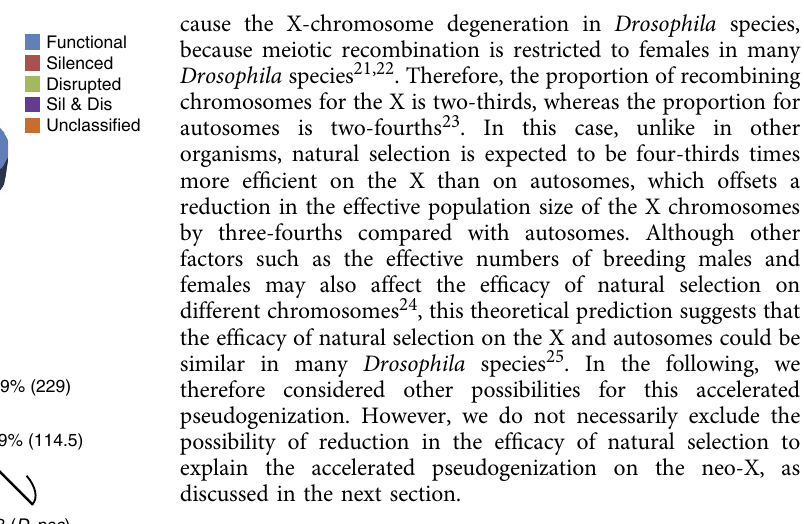
before separating the neo-X and neo-Y; X , the neo-X branch; Y , the neo-Y branch; and Pse , the D. pseudoobscura branch after splitting from D. miranda . The number of orthologues that were used for the analysis with functional genes in D. obscura is shown above the tree. The numbers in parentheses are the numbers of genes that were pseudogenized in each lineage. Results for other chromosomes are shown in Supplementary Fig. 1. Results based on different conditions are shown in Supplementary Figs 2, 3 and 4 and in Supplementary Tables 8 and pseudogenization on the neo-sex chromosomes. Further studies